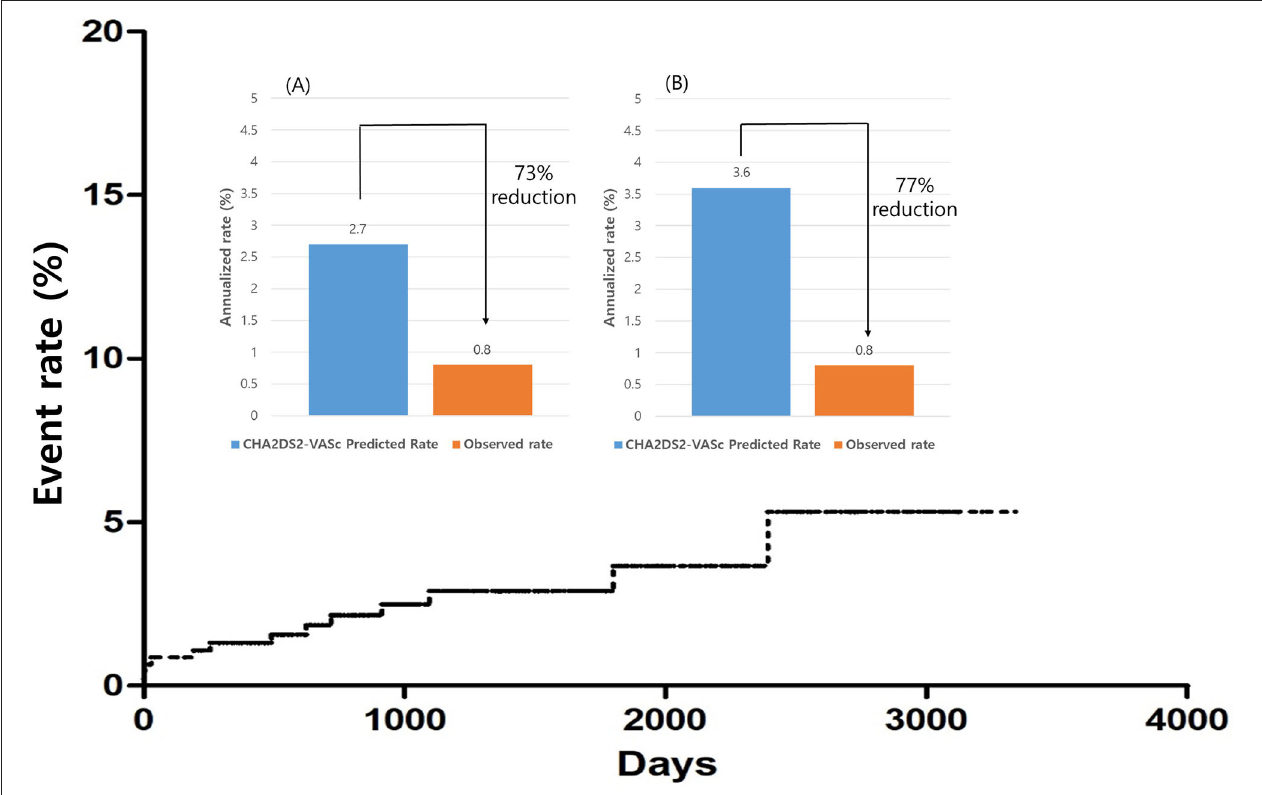
FIGURE 5 | Overall ischemic stroke event rates. Relative ischemic stroke reduction compared with the predicted rate. (A) Overall patients. (B) Patients other than that with CHA 2 DS 2 -VASc score